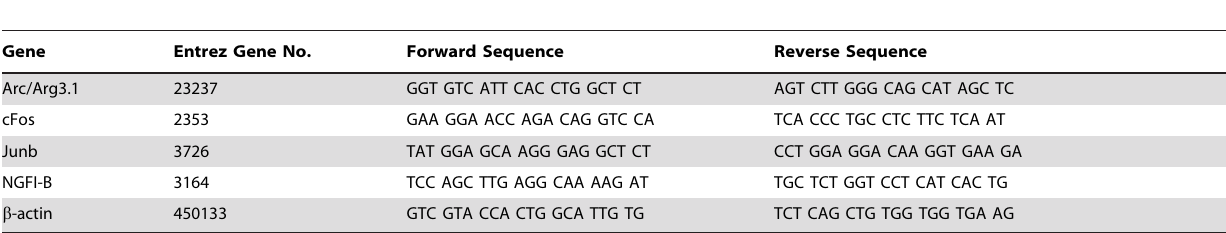
Table 1. Entrez Gene ID Numbers and Primer Sequences of Genes Used for Quantitative Polymerase Chain Reaction Experiments